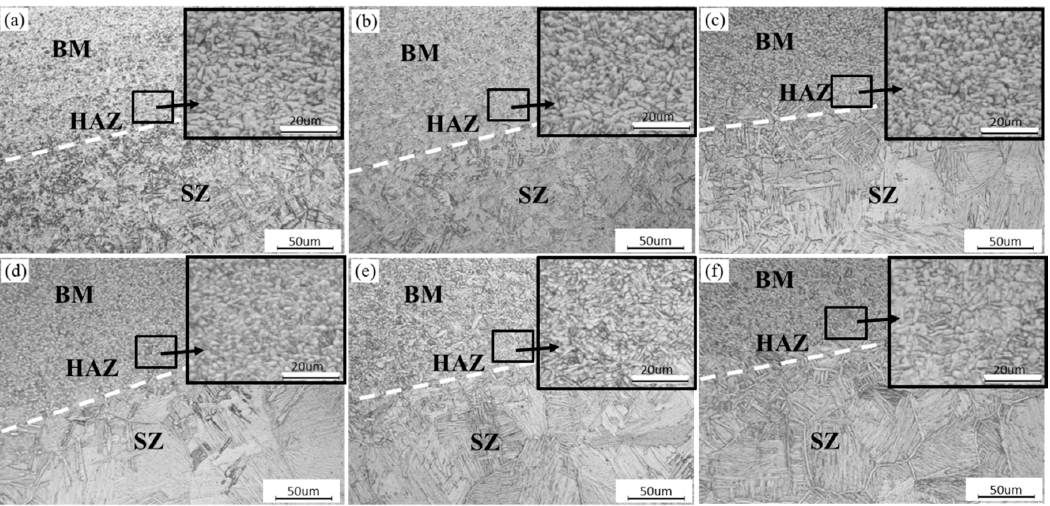
Figure 9. Microstructure of HAZ. ( a ) At 700 rpm—10 mm / min; ( b ) at 900 rpm—10 mm / min; ( c ) at 1100 rpm—10 mm / min; ( d ) at 900 rpm—20 mm / min; ( e ) at 900 rpm—40 mm / min; ( f ) at 900 rpm—60 mm /